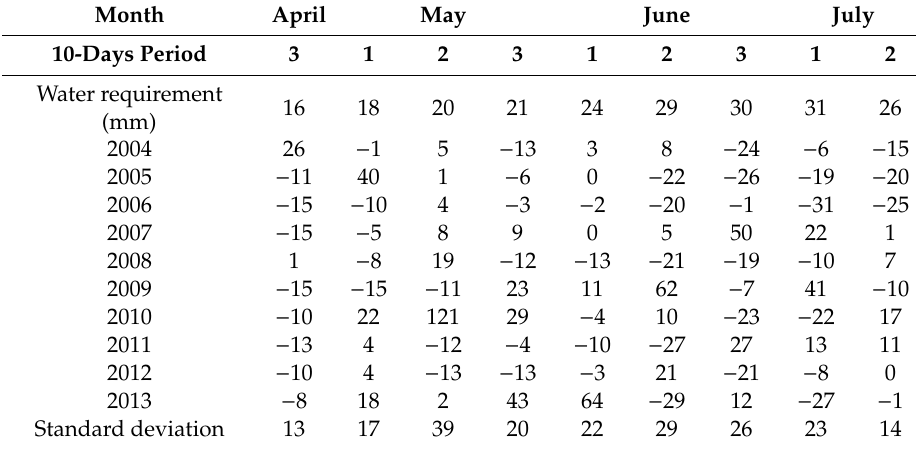
Table 2. Rainfall demand in 10-day periods during growth of very early potato according to Dzie˙zyc et al. [16] and deficiencies ( − ) and surpluses ( + ) of